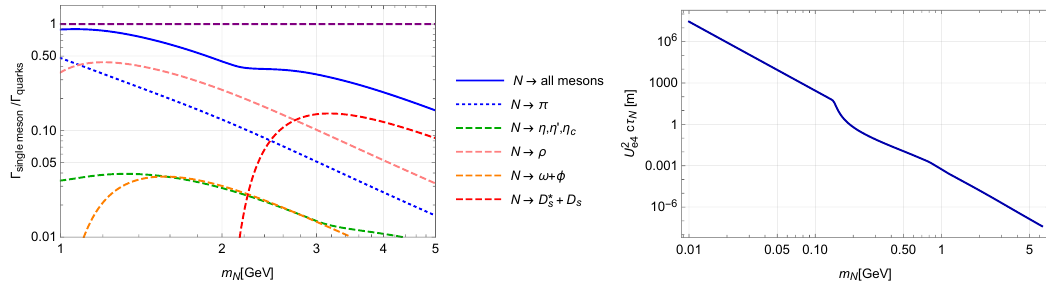
Figure 3 . Left: Comparison of branching ratios to individual mesons divided by the inclusive hadronic branching ratio calculated via eq. (4.3). Right: Decay length of the sterile neutrino in minimal